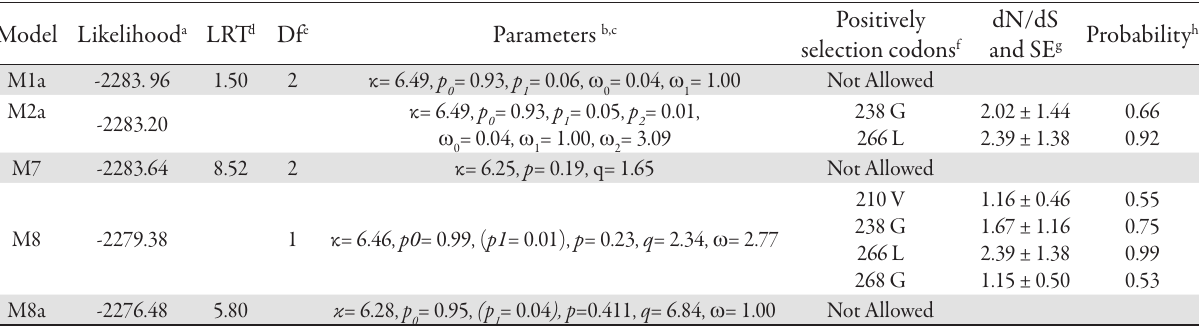
; c Parameters p and q are the shape 1